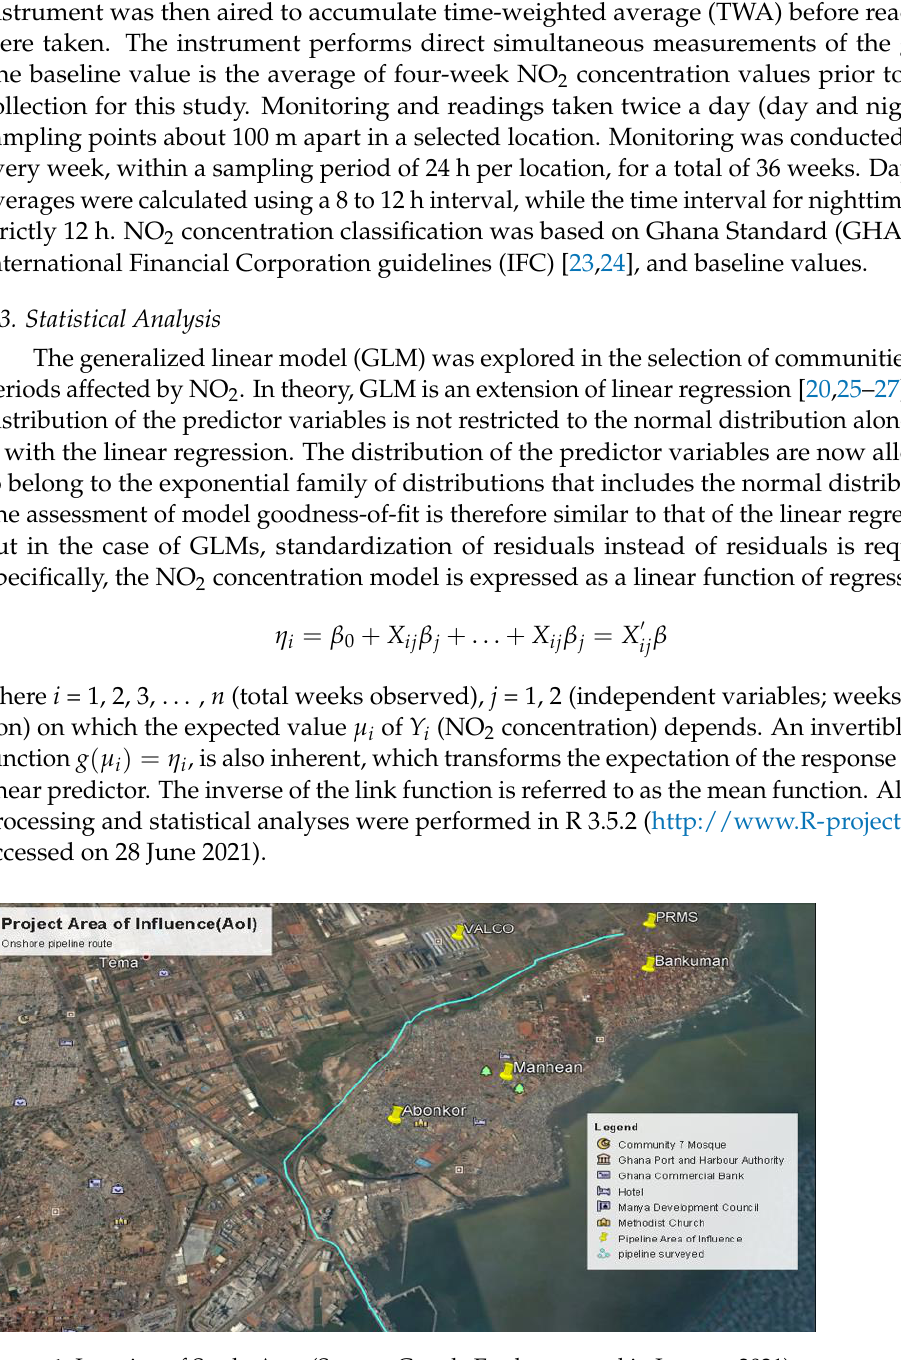
Figure 1. Location of Study Area (Source: Google Earth, accessed in January